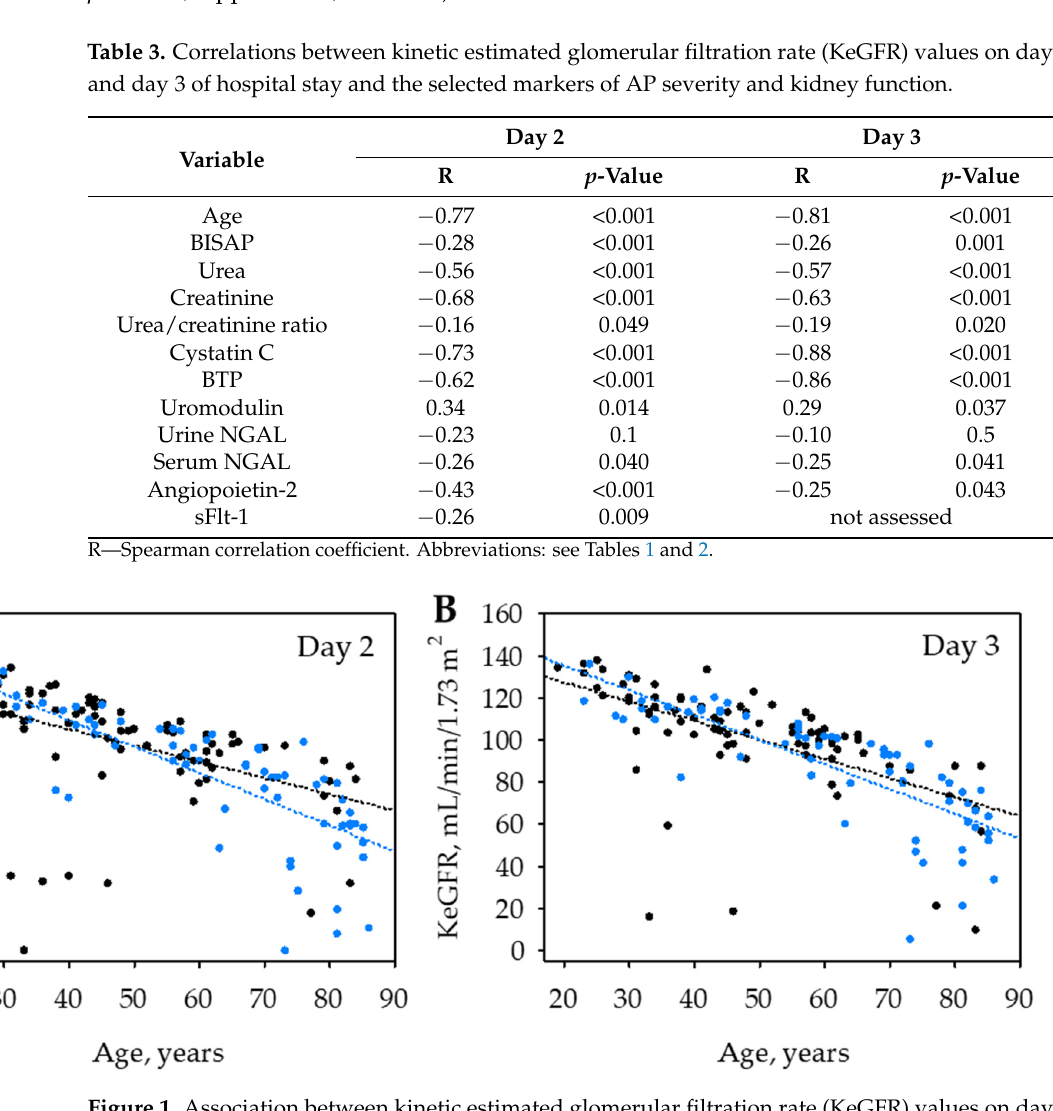
Figure 1. Association between kinetic estimated glomerular filtration rate (KeGFR) values on day 2 ( A ) and 3 ( B ) of hospital stay in patients with AP recruited in two study centers: the Department of Surgery, Complex of Health Care Centers in Wadowice, Poland (in black) and the District Hospital in Sucha Beskidzka, Poland (in blue).